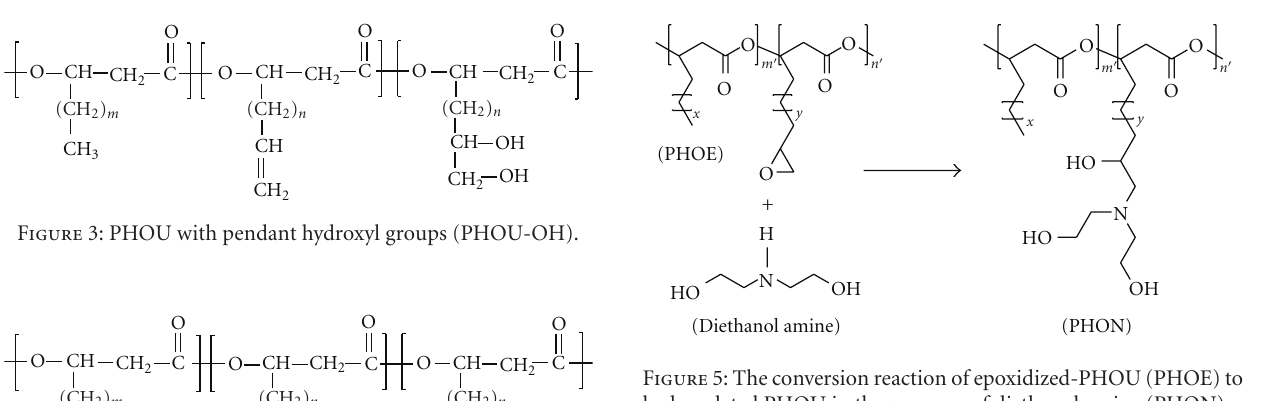
Figure 5: The conversion reaction of epoxidized-PHOU (PHOE) to hydroxylated PHOU in the presence of diethanol amine (PHON).